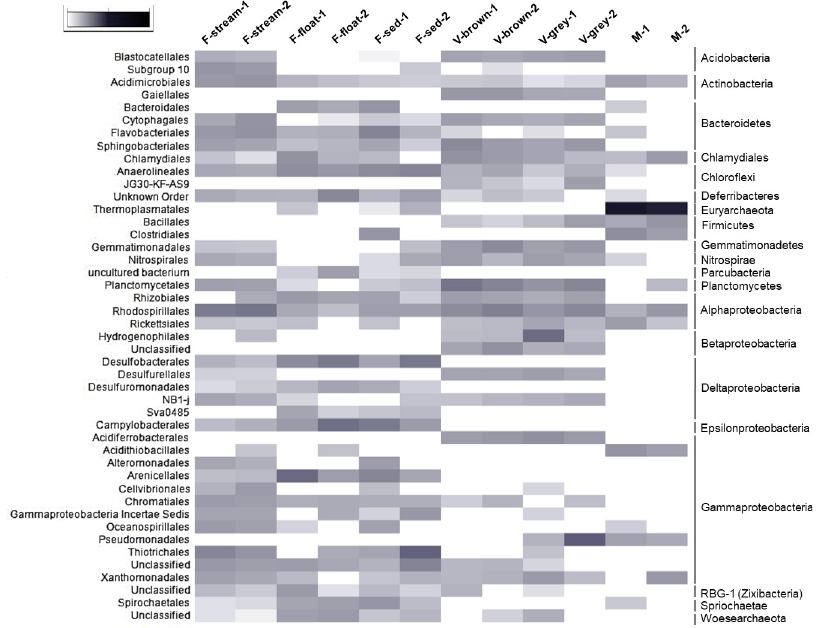
Fig 7. Heatmap showing the abundance of the microbial orders present in Fetida Cave samples. Only orders with abundance > 2% in at least one sample are reported. The higher taxonomy affiliation of the orders is reported on the right side of the